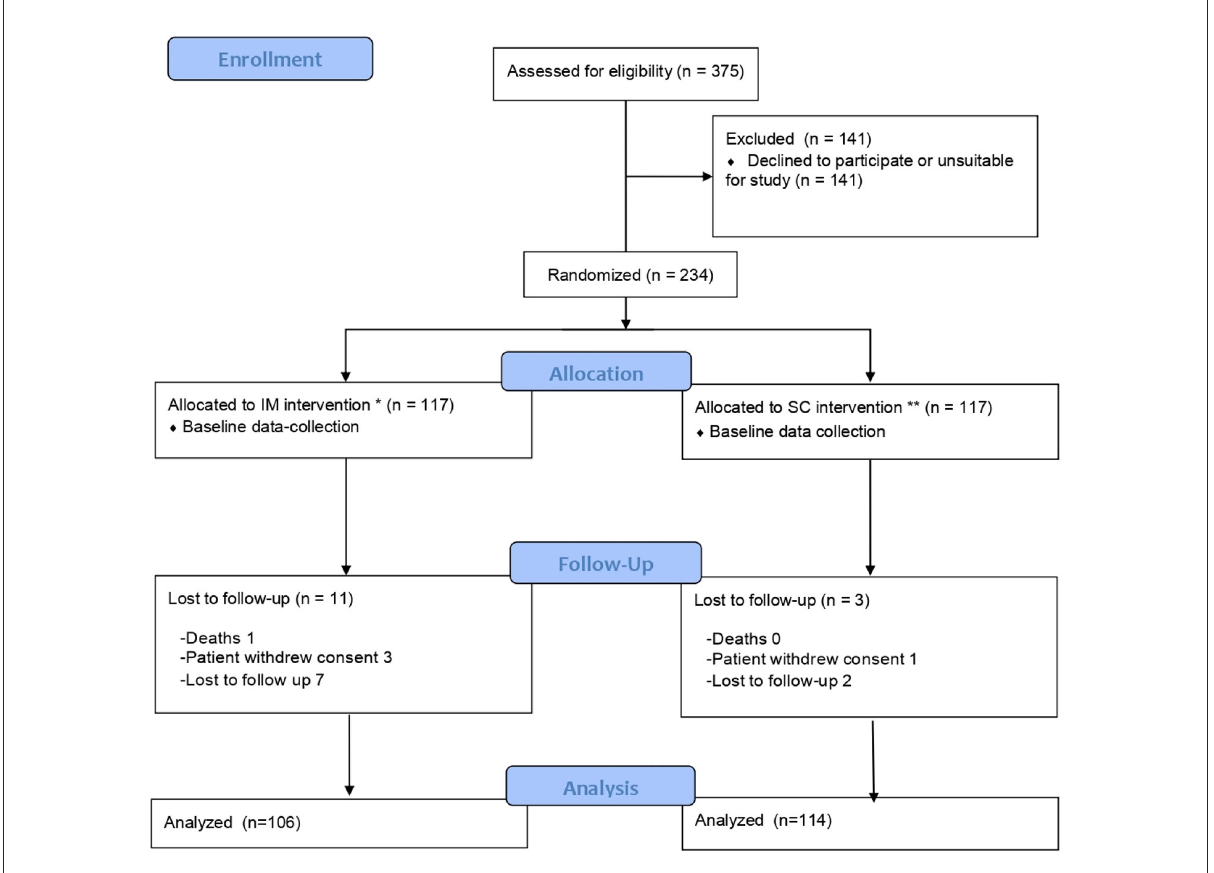
FIGURE1 Flow chart of study